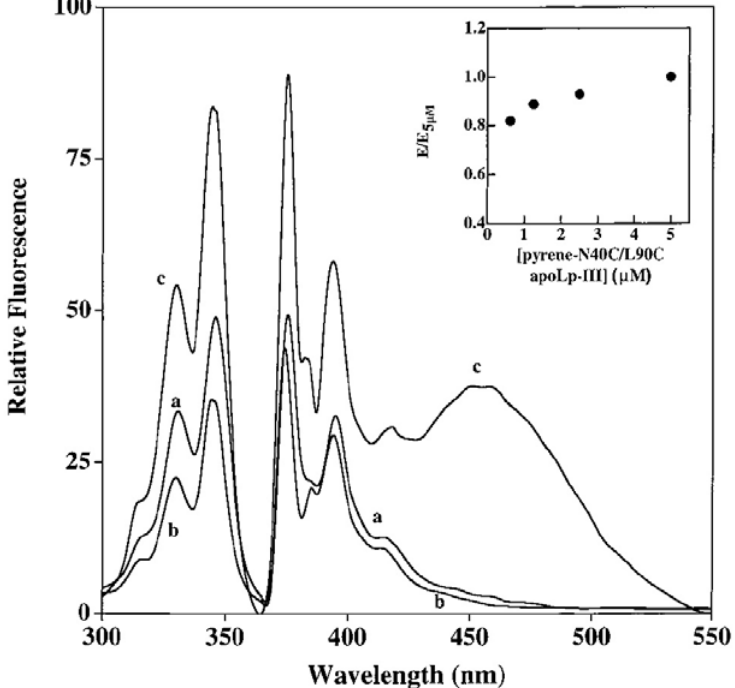
Figure 5. Fluorescence excitation and emission spectra of lipid-free single-labeled N40C-, L90C- and double labeled N40C/L90C-apoLpIII ( a , b and c , respectively). Inset shows effect of “dilution” with unlabeled apoLp-III on pyrene-labeled apoLp-III excimer fluorescence. E5 μ M = area under excimer emission curve of a 5 μ M pyrene labeled N40C/L90C-apoLp-III, and E = area at different concentrations (reproduced from [15] with permission from the American Chemical Society, ©